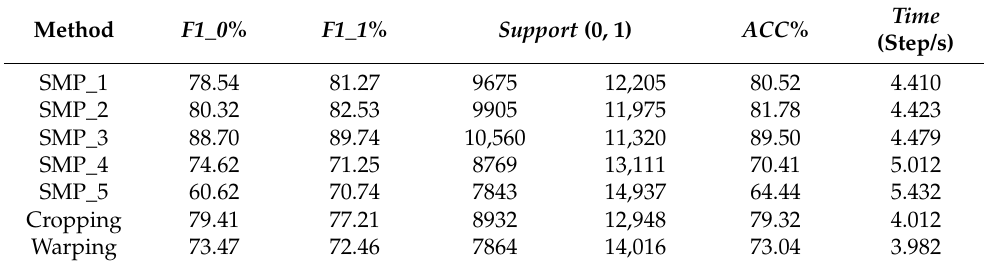
Table 3. Effect of pooling method on results.